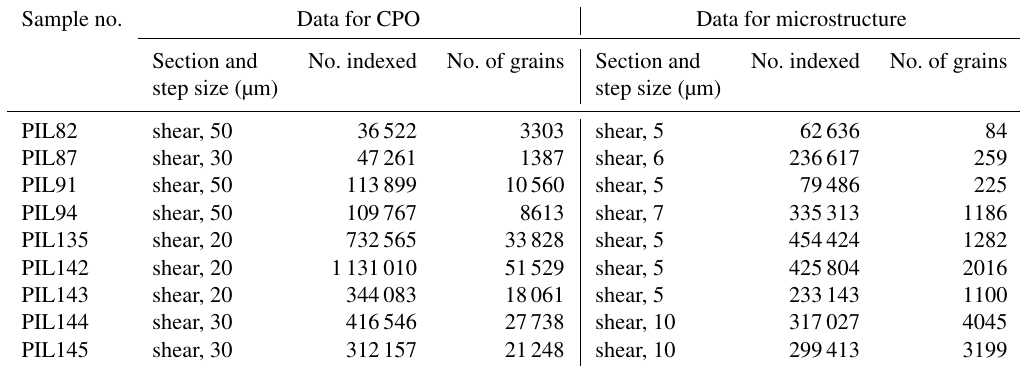
Table 2. Summary of EBSD analyses. Sample